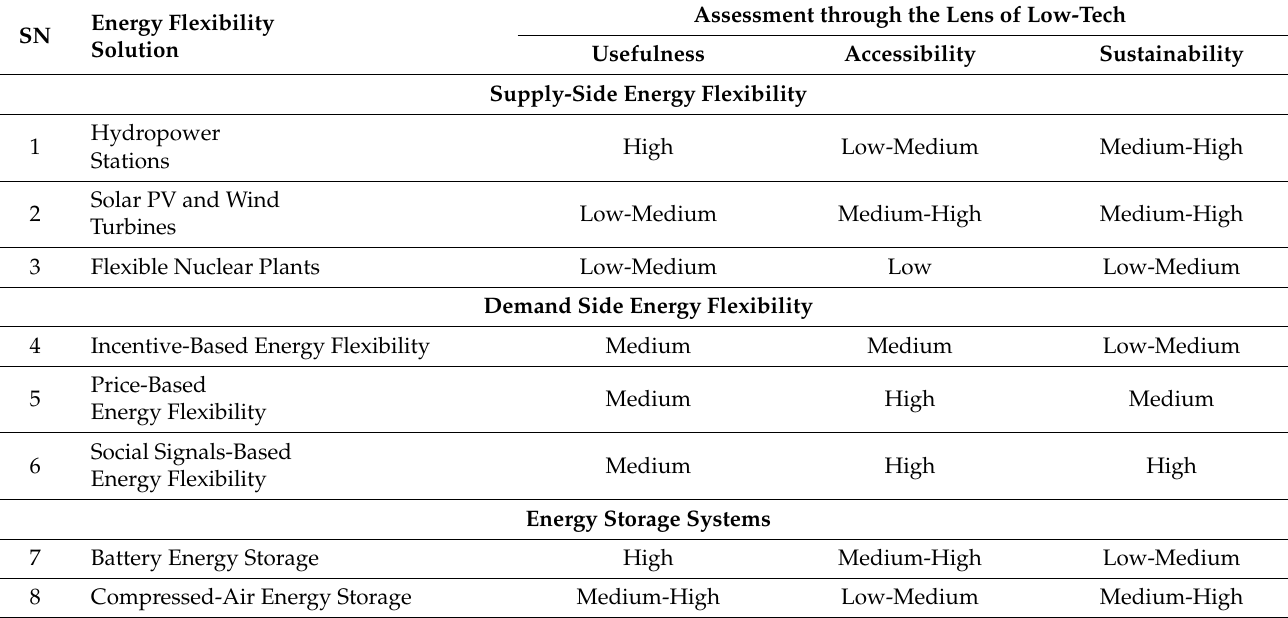
Table 1. Summary of assessment of energy flexibility solutions through the lens of